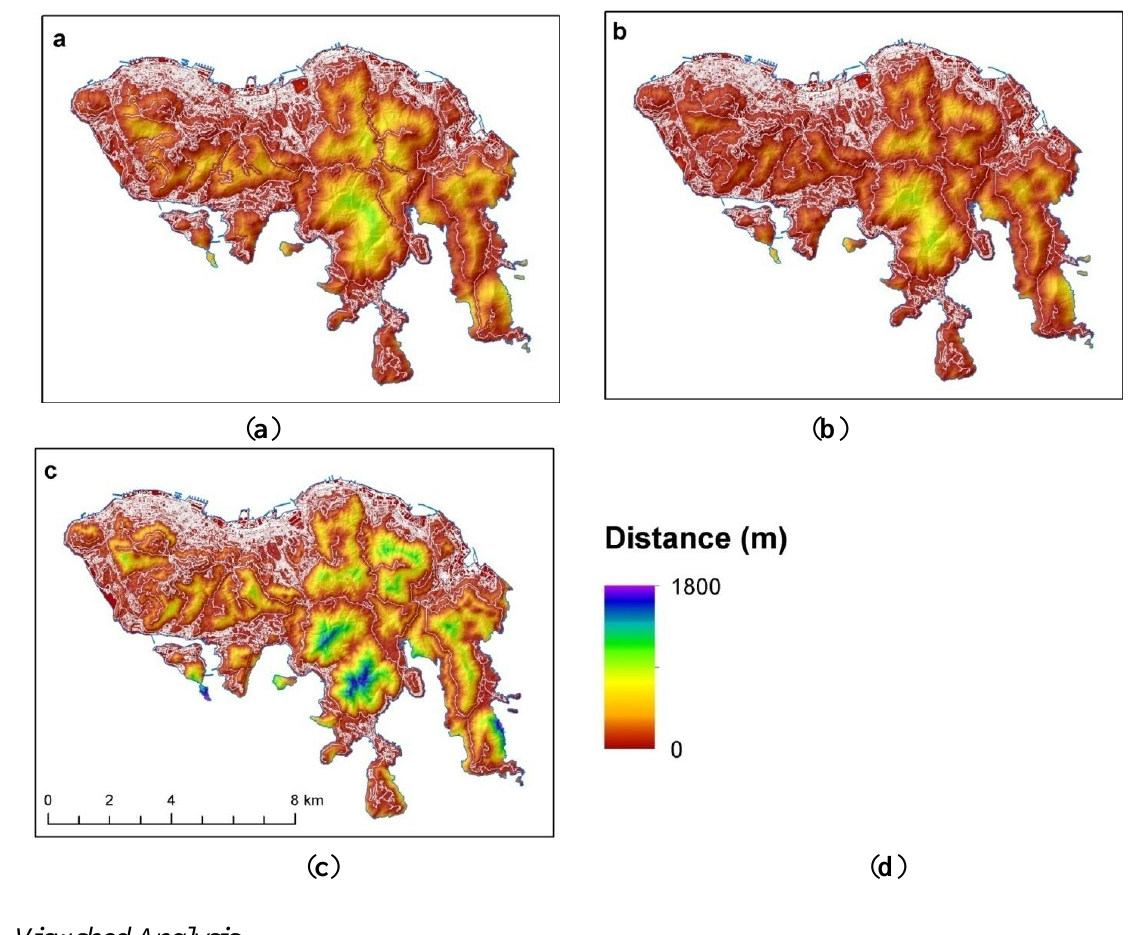
Figure 6. Comparing three distance surfaces from built-up areas and roads: weighted distance (landscape continuity values) ( a ), Euclidian distance ( b ), Euclidian cost-distance using slope as the friction surface ( c